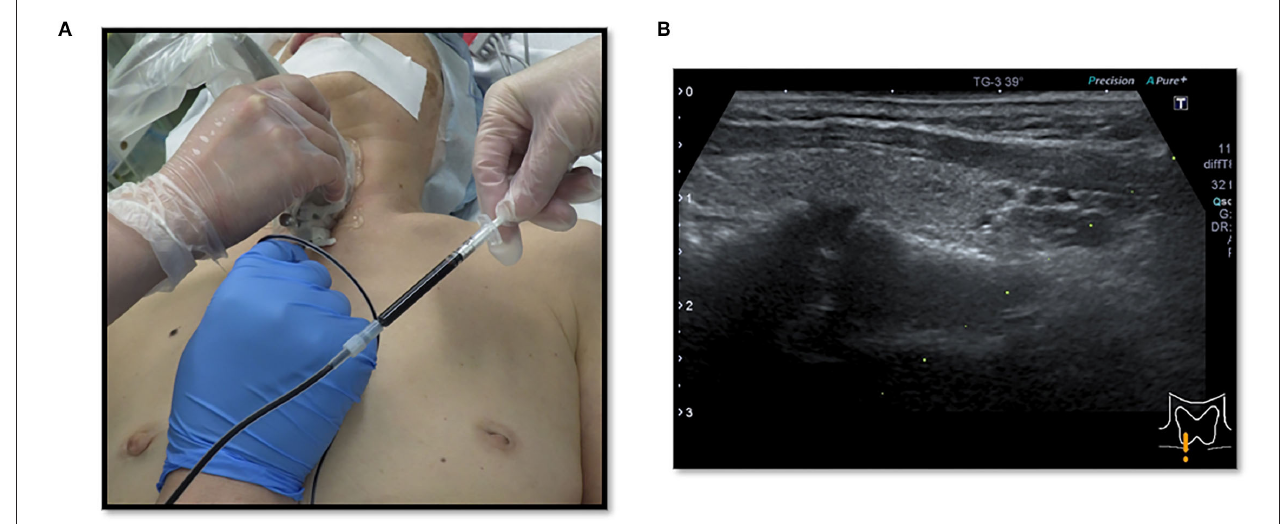
FIGURE 2 | (A,B) Cervical neck ultrasound-guided injection of indigo carmine for marking EPA (dye